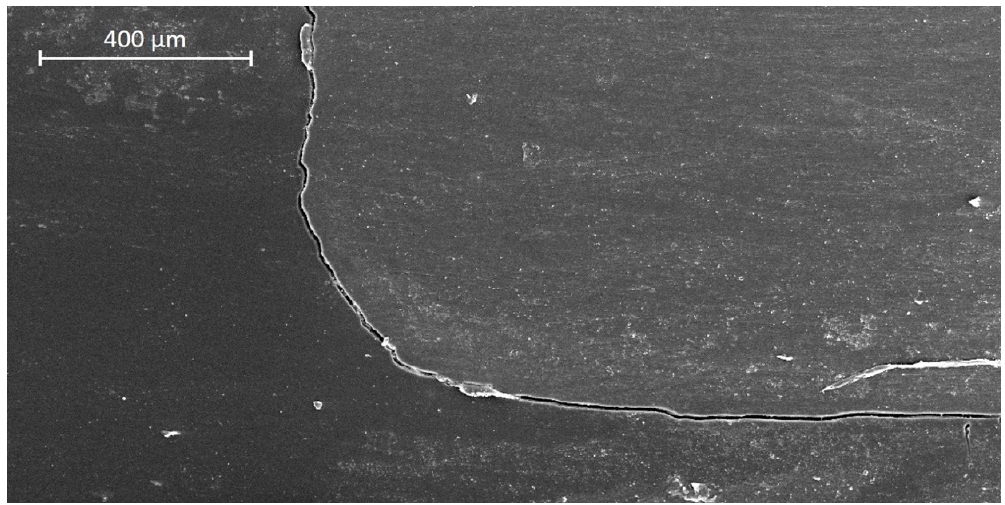
Figure 7. SEM image of non-continuous margin in dentin (group 5: Venus Bulk Fill (VBF), after thermo-mechanical loading).